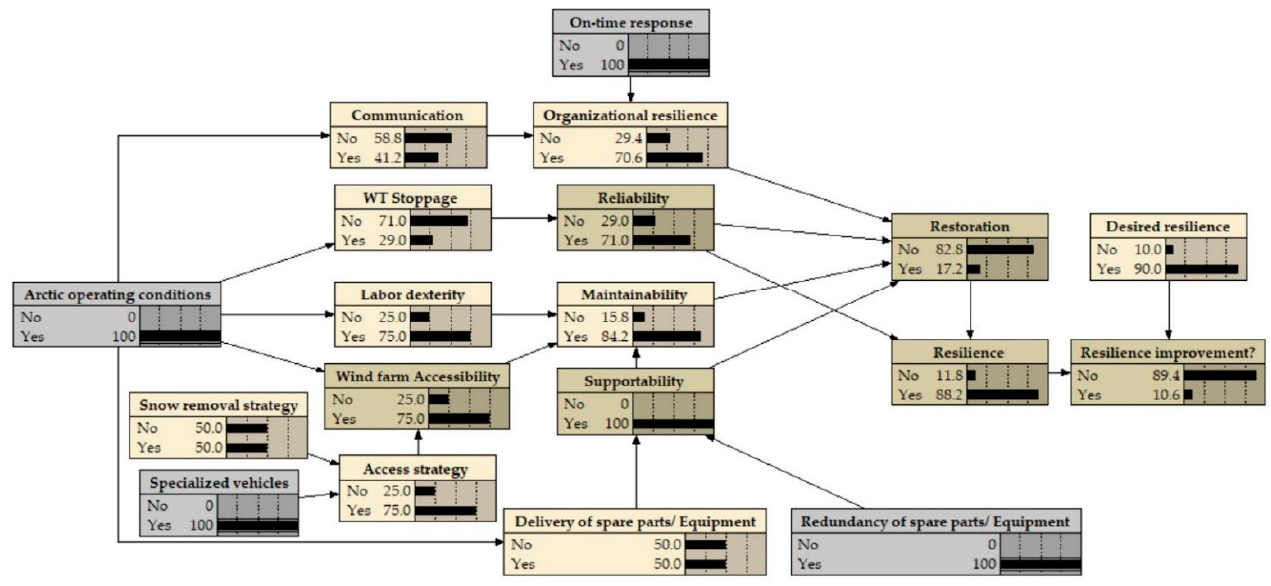
Figure 6. Bayesian network for calculating resilience in Arctic operating conditions scenario.